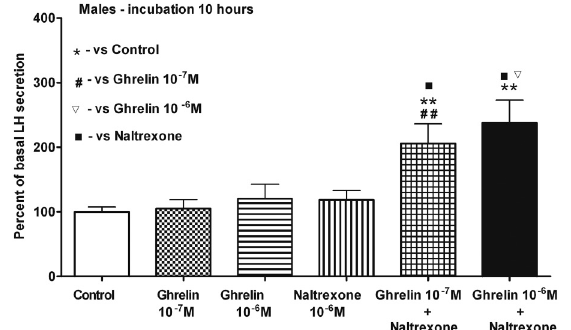
Fig. 3. Percentage of basal LH secretion from male pitu- itary cells incubated for 10 h with control